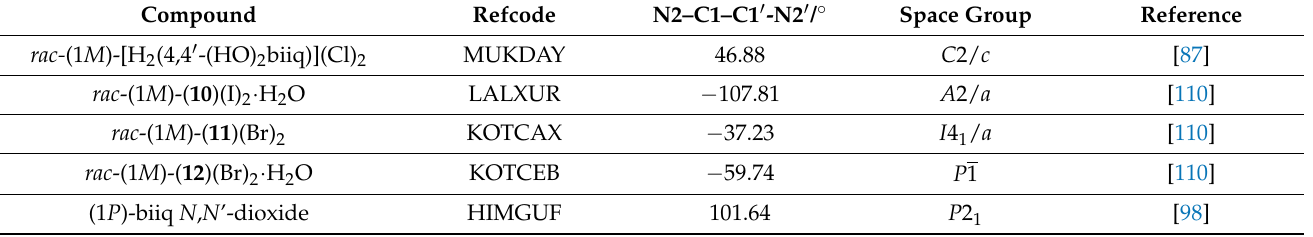
Table 2. Structurally characterized quaternized 1,1 (cid:48) -biisoquinolines and related species.